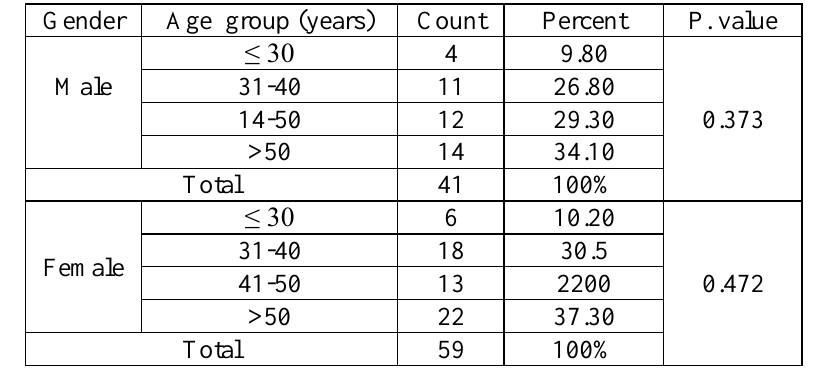
Table 3: Distribution of patients by gender and age groups